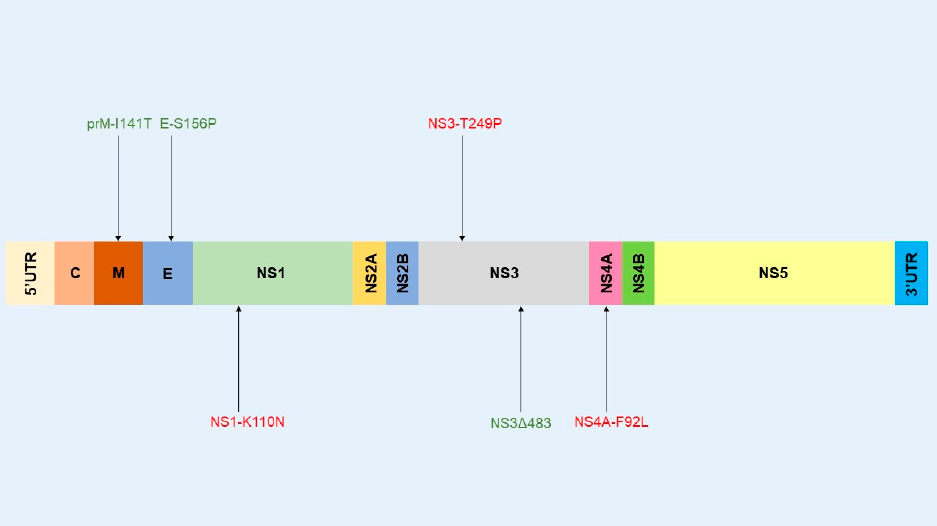
Figure 7. Virulence determinants in the WNV genome found in avian hosts. Molecular virulence determinants validated in vitro in the DEF avian cell line or in vivo in American crows, house sparrows, red-legged partridges, and specific-pathogen-free (SPF) chickens. Green: mutations involved in attenuated viral phenotype. Red: mutations involved in more virulent viral phenotype. Table 1. Comparison of molecular virulence determinants of WNV in mammalian, avian, and insect models. The table details most of the residues involved in virulence variation in vivo and in vitro, as well as mutations or deletions most often observed. Green: mutations that decrease virulence. Red: mutation that increase virulence.